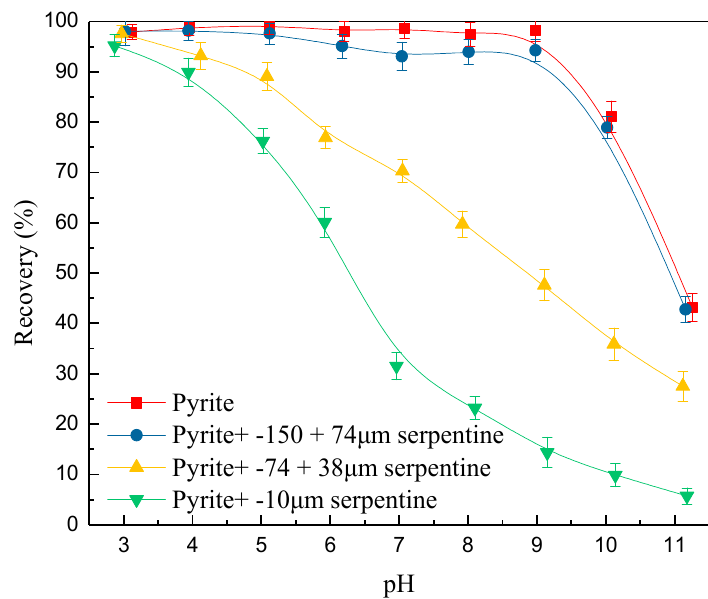
Figure 2. Effect of serpentine with different particle sizes on the flotation of pyrite as a function of pulp pH (potassium butyl xanthate [PBX] = 3.75 × 10 − 5 mol/L, methyl isobutyl carbinol [MIBC] = 2 × 10 − 4 mol/L).